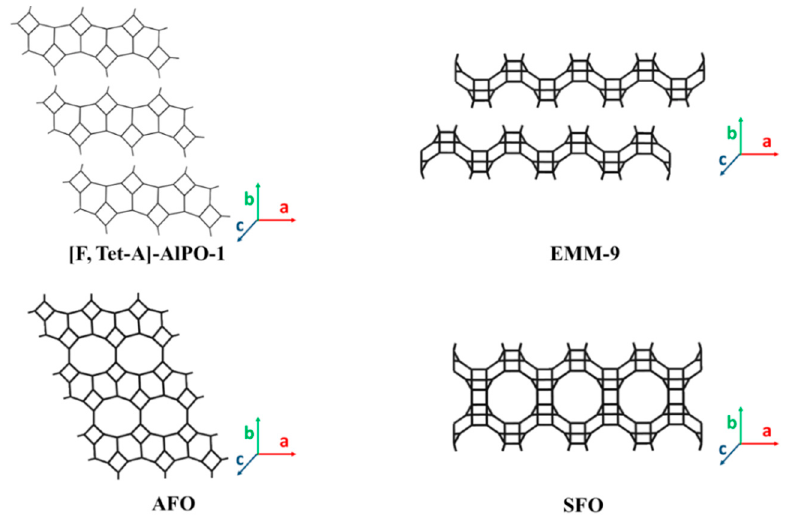
Figure 7. Schematic illustration of structures of 2D layered [F, Tet-A]-AlPO-1 and EMM (ExxonMobil Material)-9, as well as their corresponding 3D AFO ((AlPO 4 -41 (forty-one)) and SFO ((SSZ (Standard Oil Synthetic Zeolite)-51 (fifty-one)) zeolitic aluminophosphates.